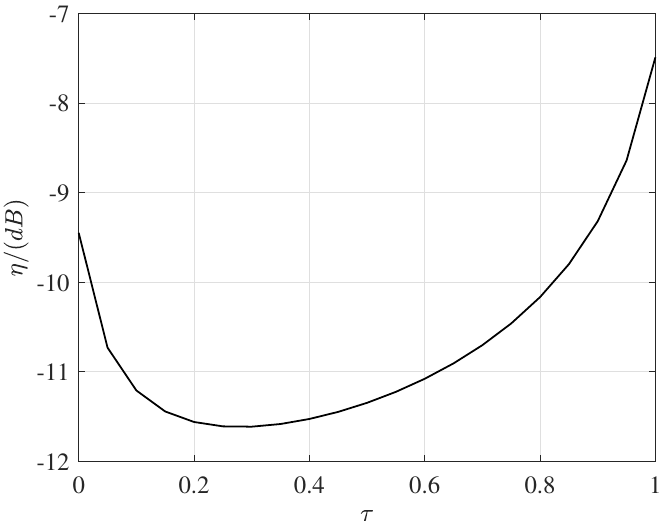
Figure 11. The NMSE of the sound pressure η at uncontrolled points. The reverberation time RT 60 = 200 ms and the control filter length J =